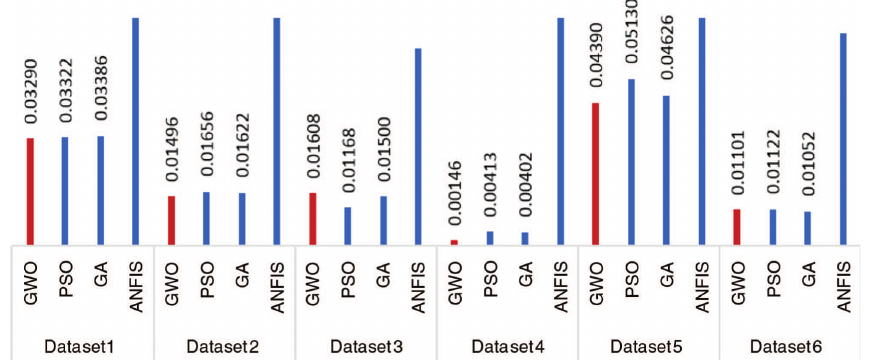
Figure 4: Results of the MSE